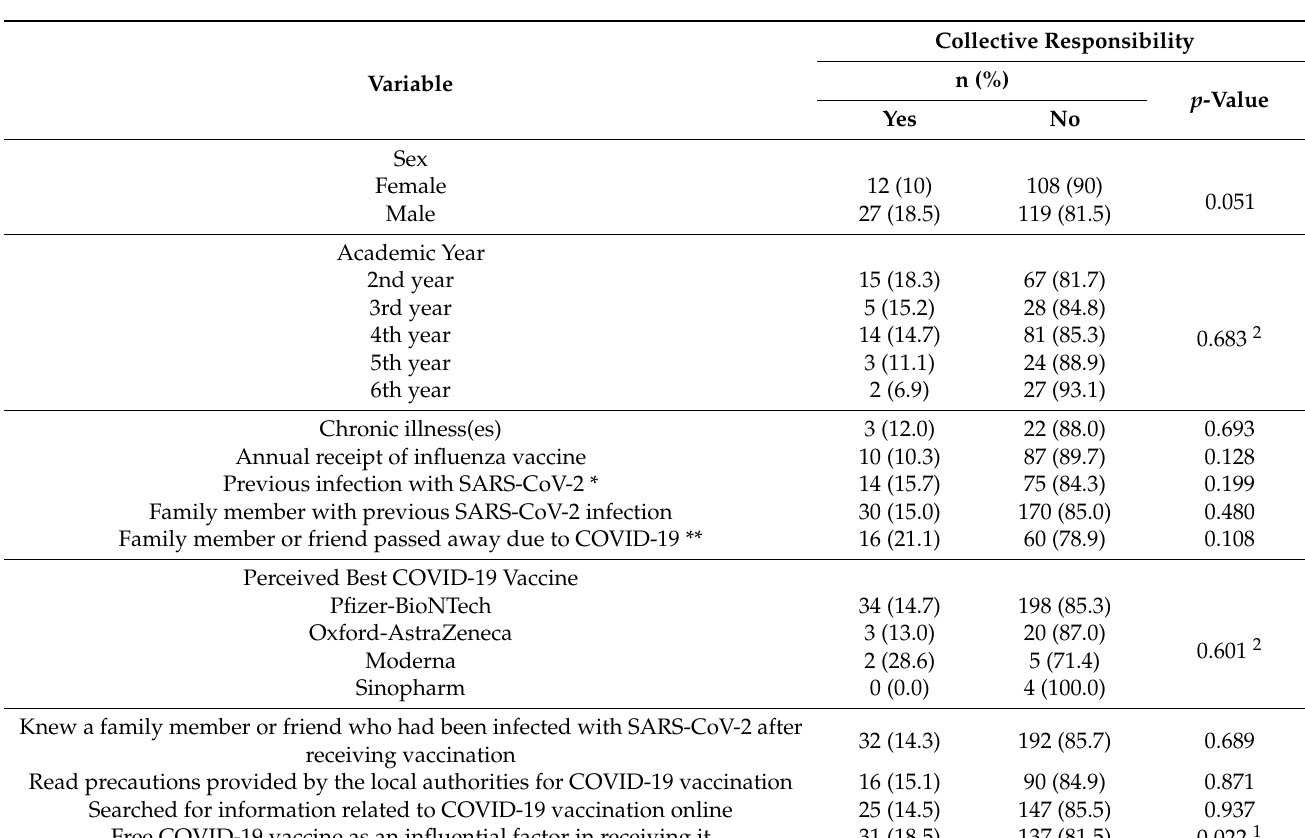
Table 7. Subgroup analysis—collective